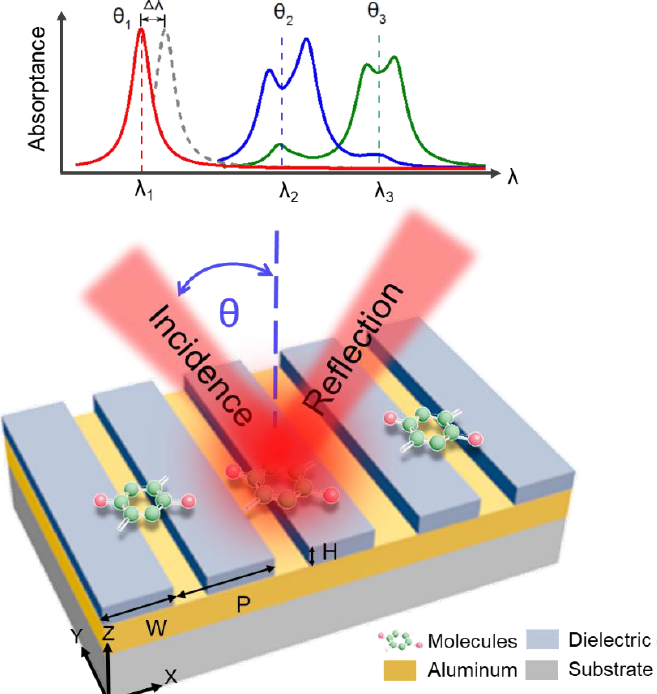
Figure 1. Schematic of the surface-enhanced infrared sensor employing narrowband perfect absorber based on dielectric-metal metasurface.